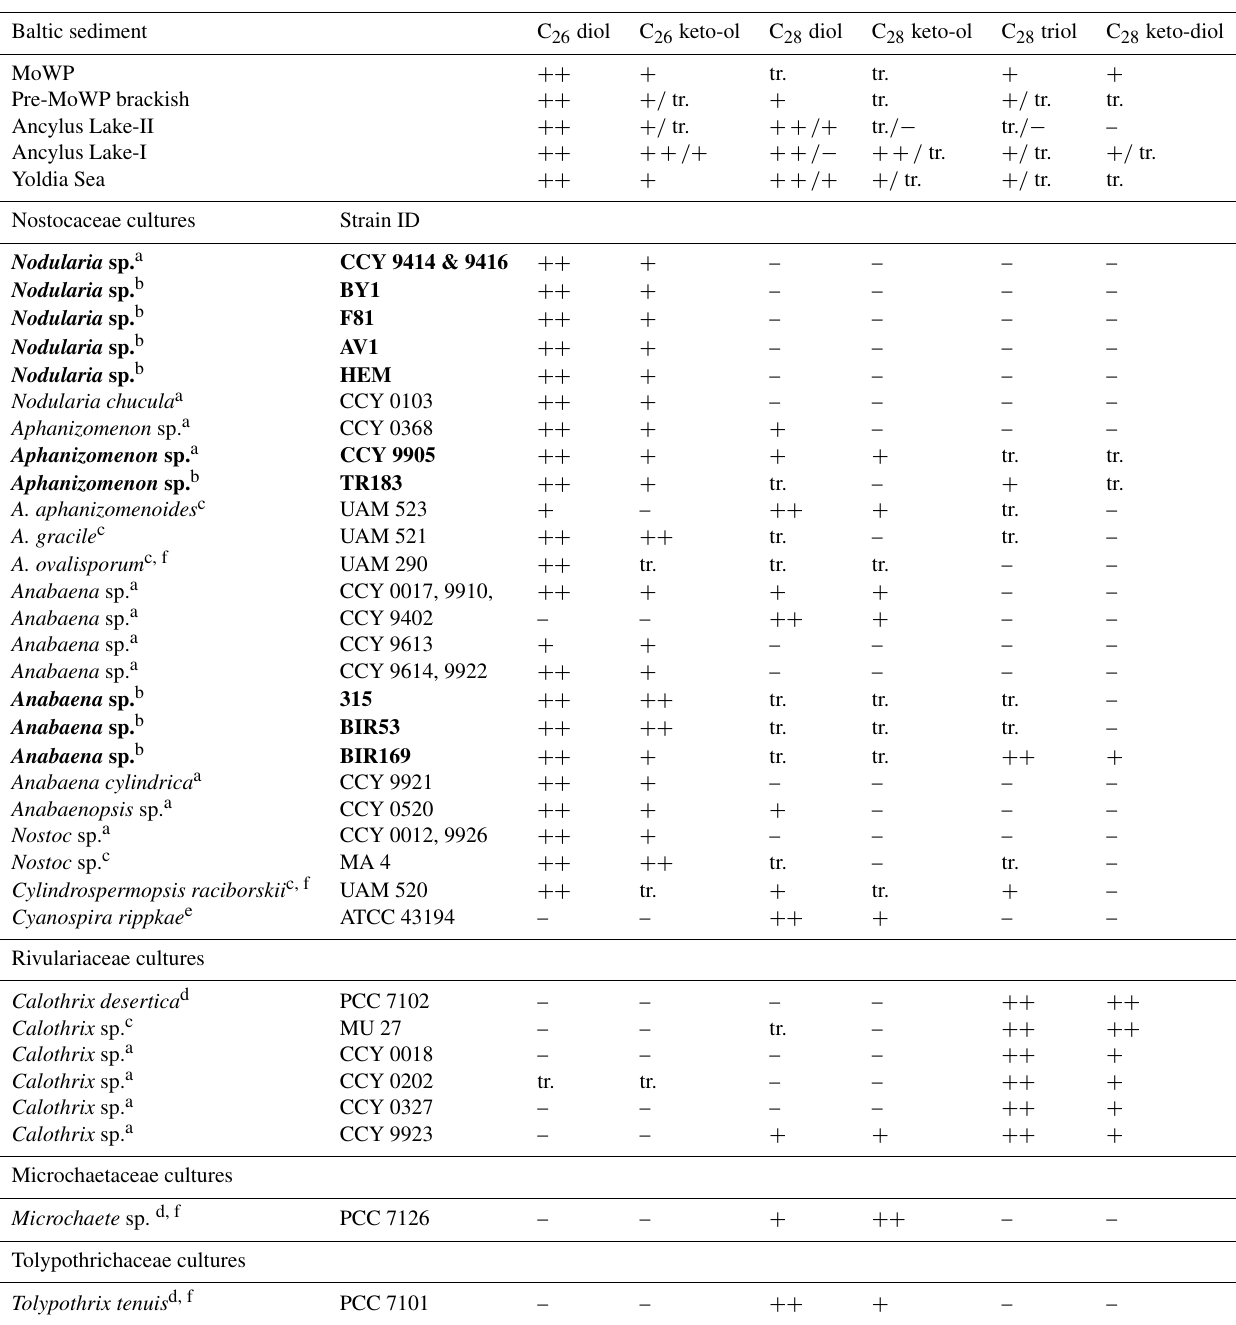
Table 1. Distribution of the six targeted HGs in sediments from this study and from cultures of selected heterocystous cyanobacteria. Key: ++ – dominant ( > 25%); + – minor presence (5–25%); tr. – traces ( < 5%); – – not detected or not reported. Bold strains were isolated from the Baltic